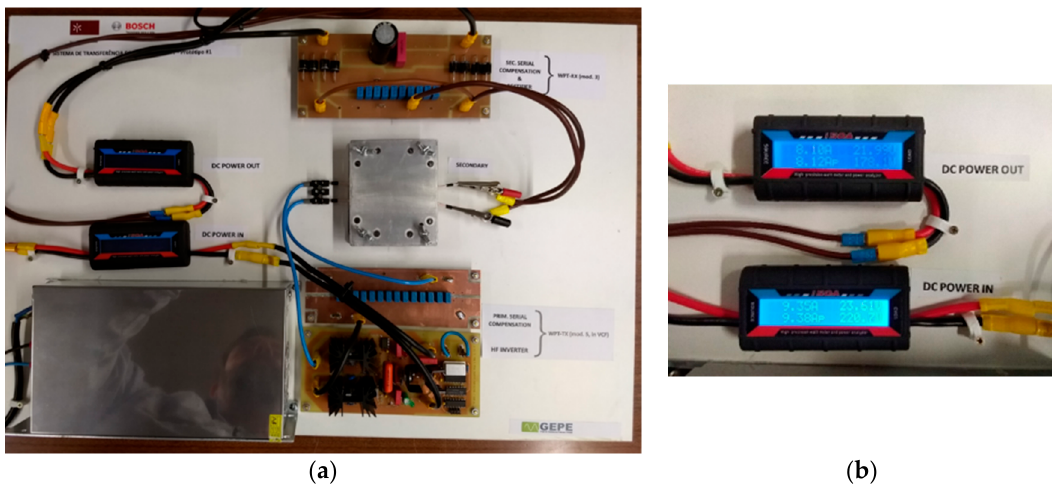
Figure 10. ( a ) First conceptual prototype of the WPT subsystem of the LiDAR, achieving more than 175 W at 80.5% efficiency. ( b ) Approximate input and output power readings, using DC power meters.